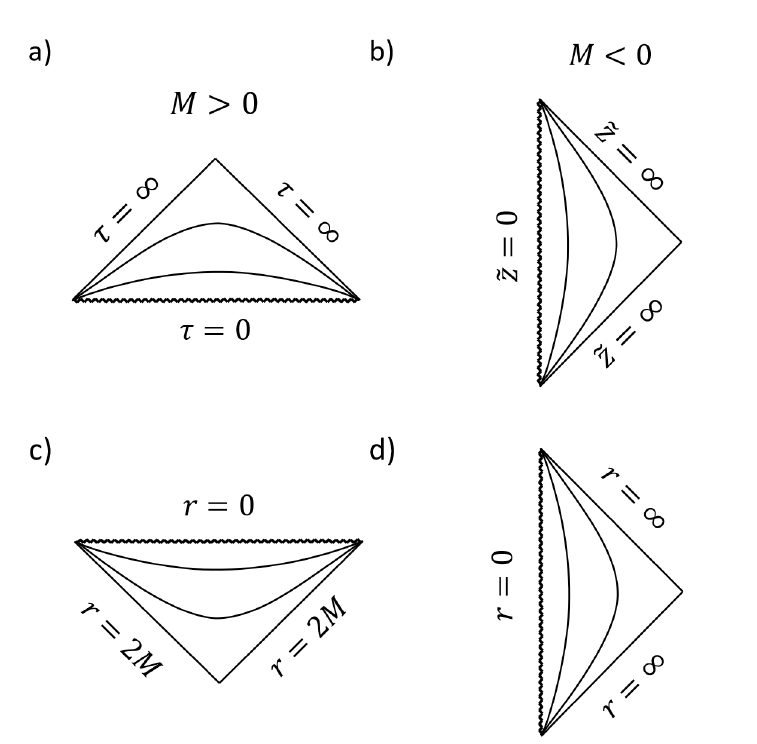
Figure 1. Conformal (Penrose) diagrams: ( a ) Kasner solution; ( b ) Taub solution; ( c ) interior of a positive-mass Schwarzschild black hole; ( d ) negative-mass Schwarzschild. Time flows from the bottom (past) to the top (future) in each